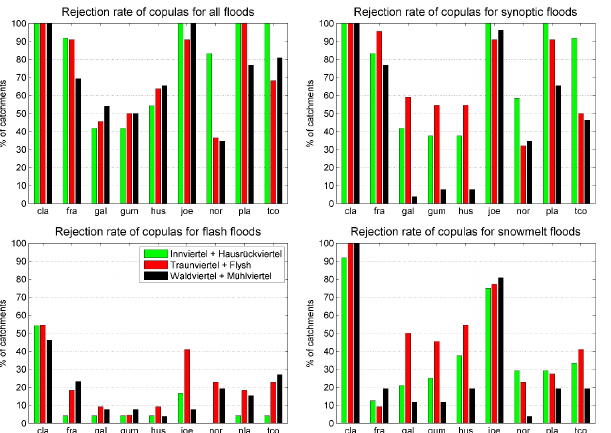
Figure 4. Results of the goodness-of-fit test of the selected nine copula types within the three subregions (indicated by colors), for the all the floods merged in a single data set (top left) and for flood types treated separately. The bars indicate per cent ratio of the catch- ments where the given copula type was